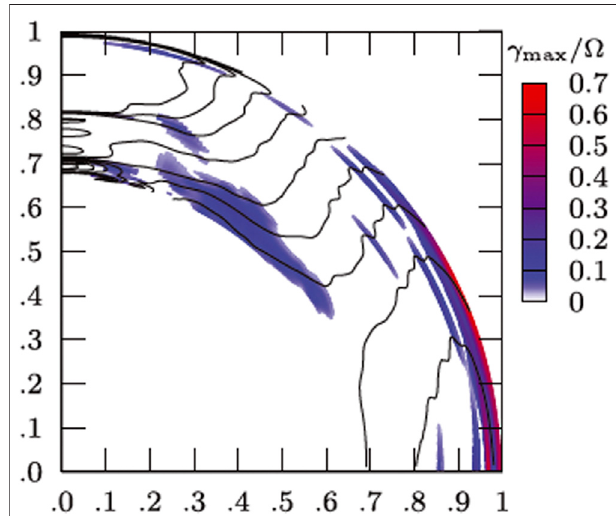
FIGURE 15 | Maximum growth rate of the MRi, c max , is shown by the colour map. The normalization is the local angular velocity Ω . The region with the positive growth rate is the promising MRI location. The rotation pro fi le is overplottedbythesolidcontourlines.Theyincreaseby15 nHzfrom330 to 480 nHz. Note that the region with zero growth rate of the MRI is fi lled with white. Reproduced from Masada (2011) by permission of Oxford University